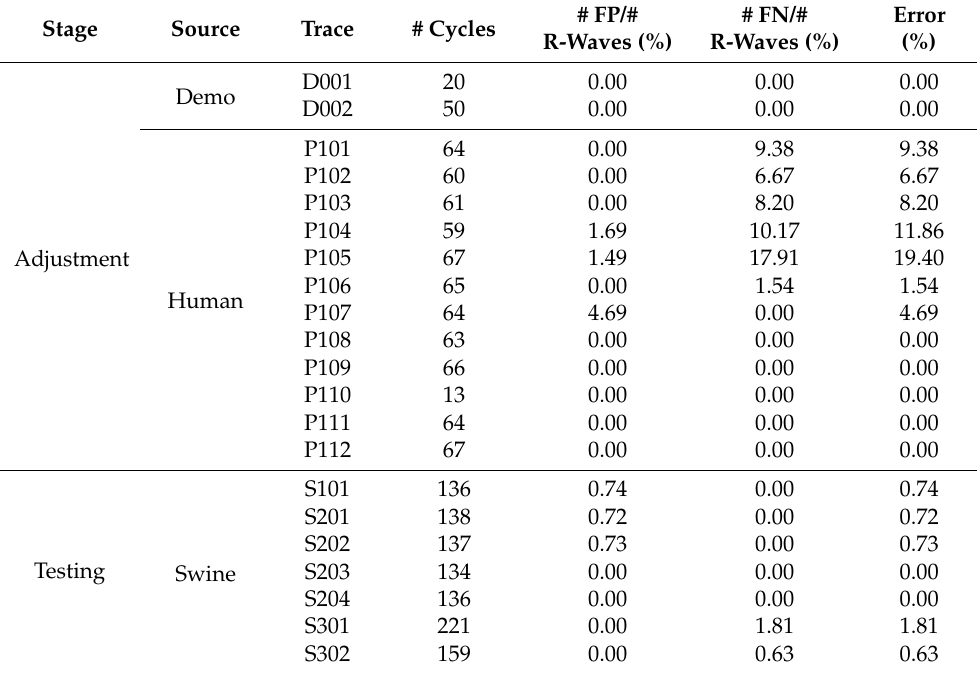
Table 1. Quantification of the errors that occurred for every trace measured (# stands for “number”).